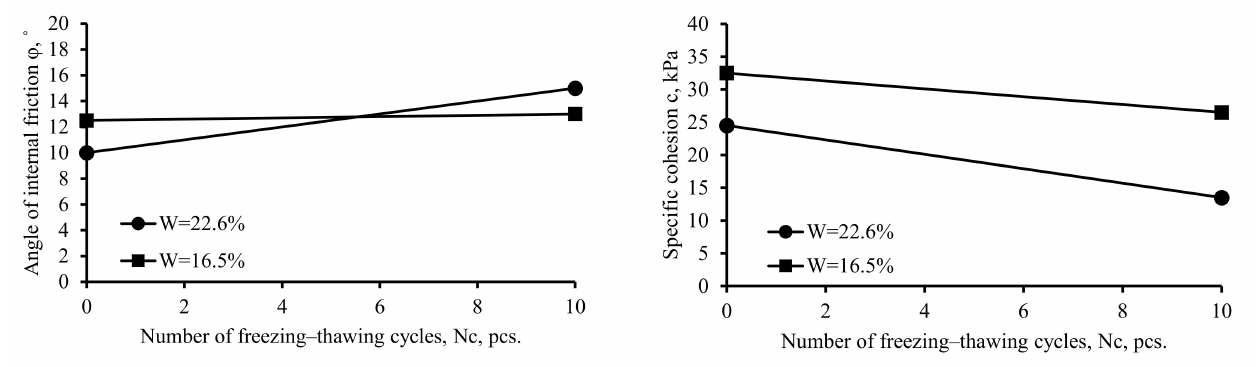
Figure 5. Effect of the interaction of factors X 2 X 3 on the strength characteristics of soil.